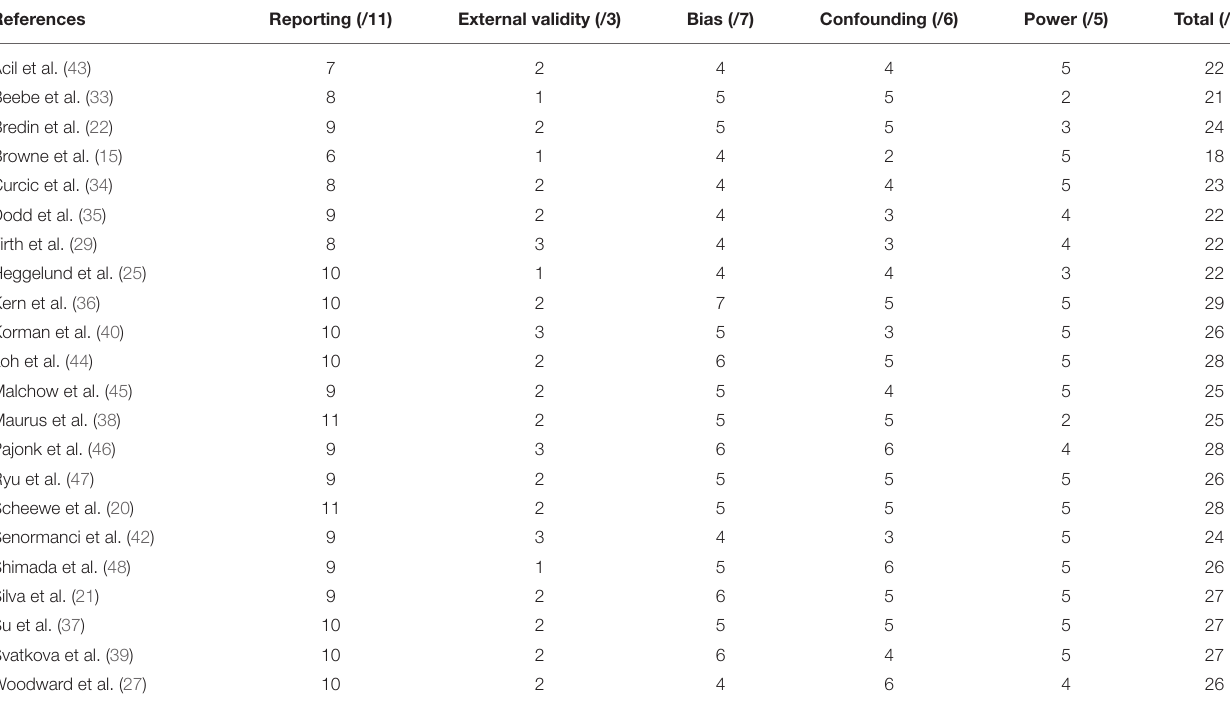
TABLE 2 | Downs and black quality index assessment for methodological